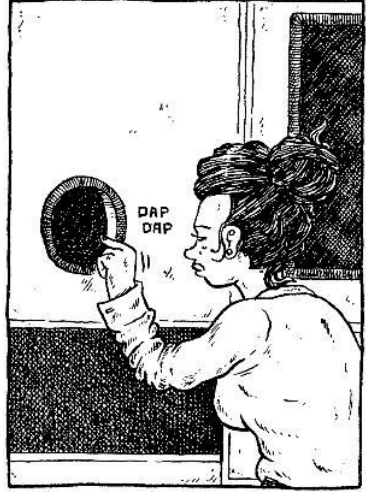
Figure 7. From Cotter, Nod Away , 58. Copyright, 2016, Joshua W